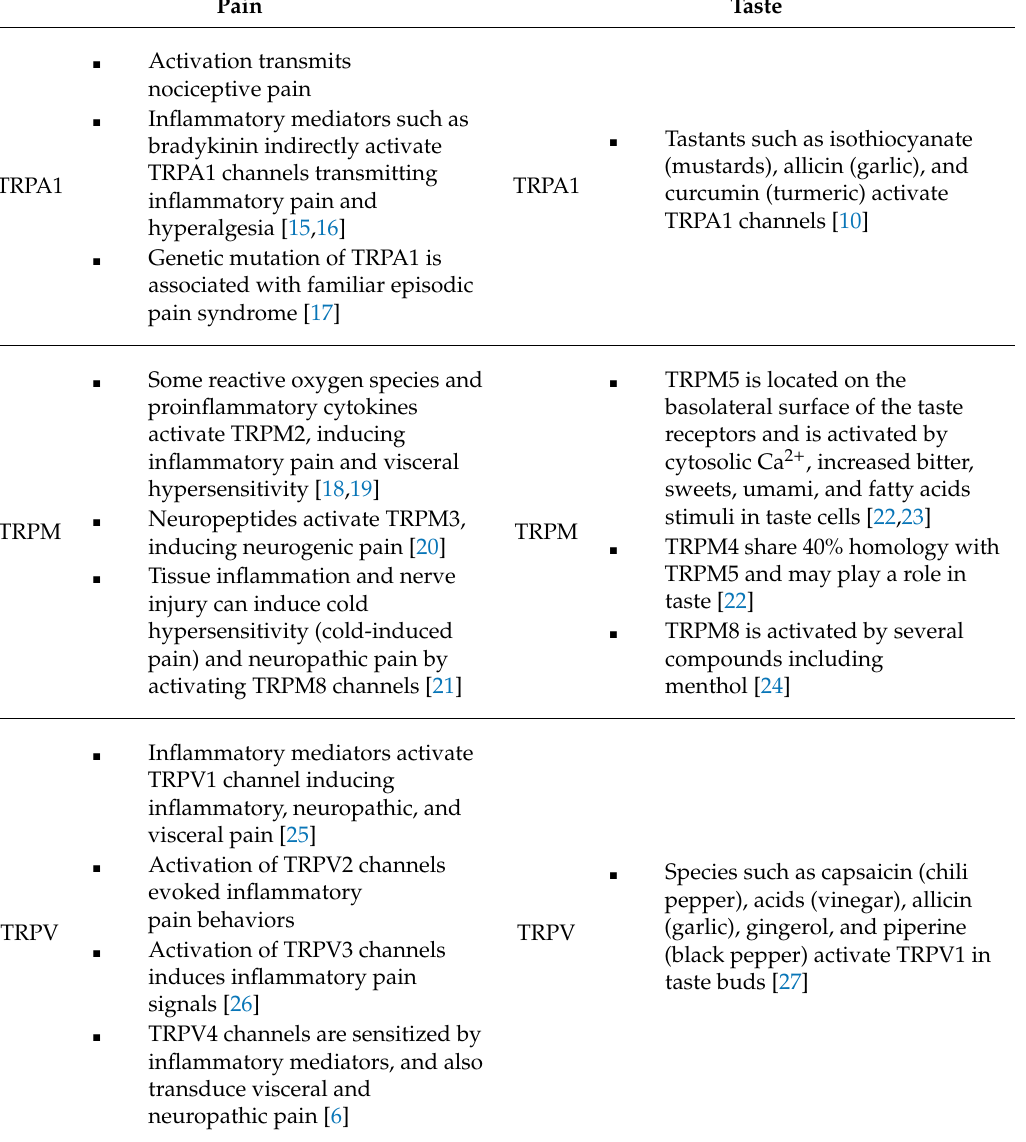
Table 1. Role of transient receptor potential (TRP) channels in pain and